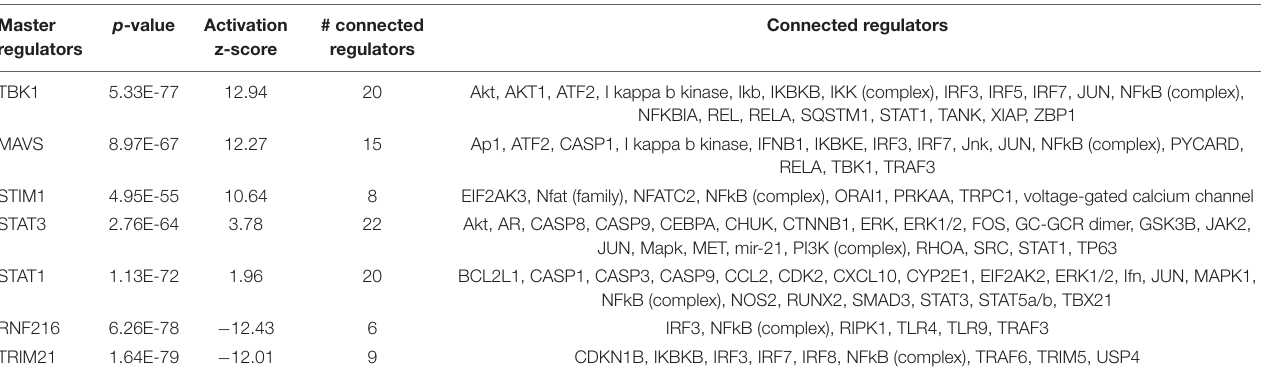
TABLE 3 | Top master regulators altered by intrauterine inflammation in placenta.